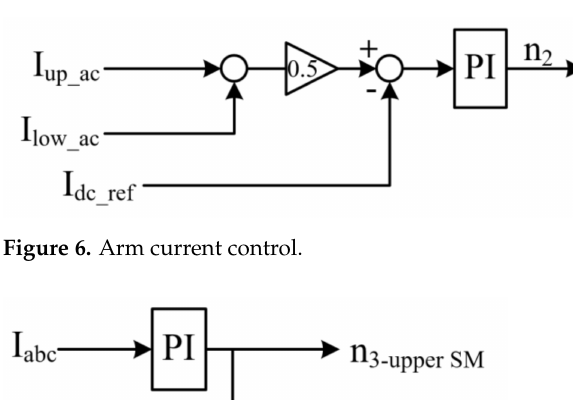
Figure 5. DC line voltage control.